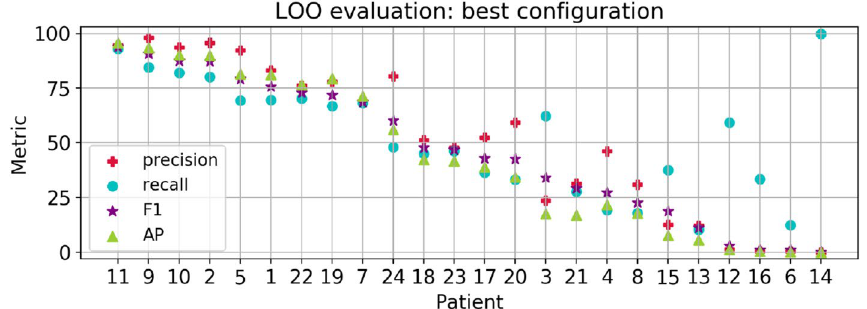
Figure 2. Results for the LOO model with the best configuration. Patients in the x-axis are sorted by decreasing F-measure (purple star marker).